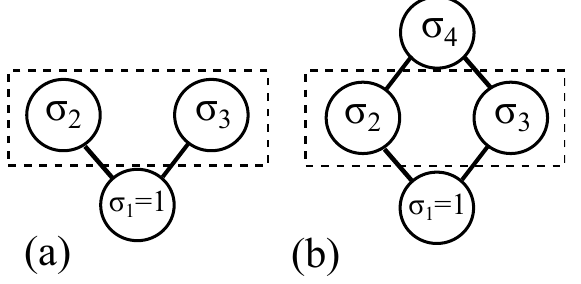
Figure 1. Two geometries of an Ising model; in both cases one knows the bottom lattice site = 1 . A dashed box indicates the subsystem of interest. The central example is where is σ 1 one does not know whether the geometry is that of Figure 1a or